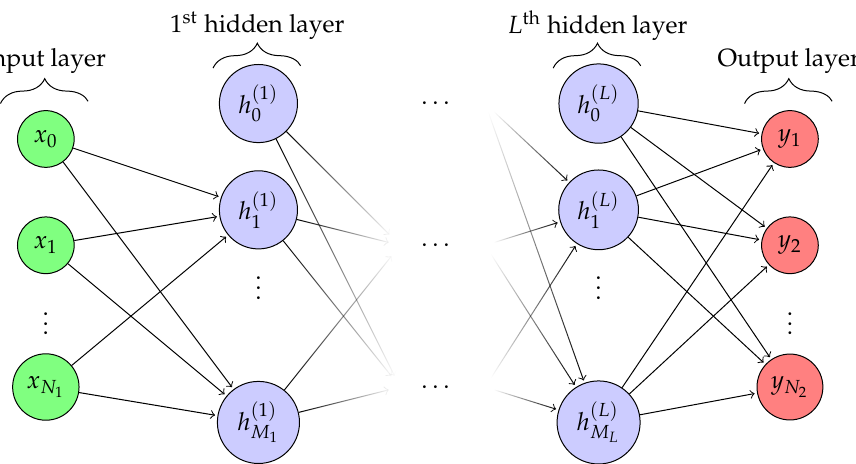
Figure 1. Network graph of N 1 input units, N 2 output units and L -layer perceptron where each hidden layer contains M j hidden units.